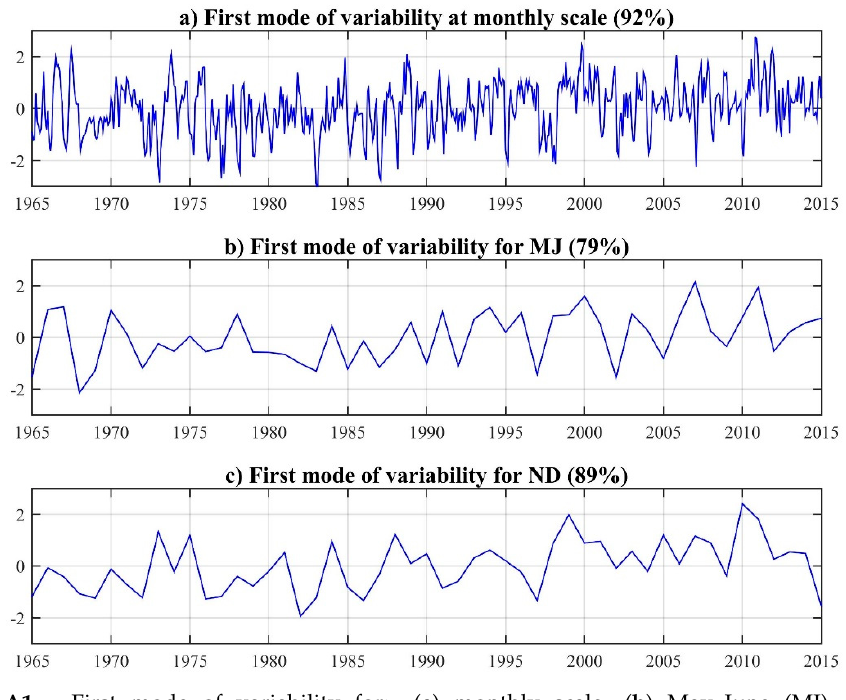
Figure A1. First mode of variability for: ( a ) monthly scale, ( b ) May–June (MJ), and ( c ) November– December (ND). Table A1. Stream gauge station significant correlations at the 0.05 Table A1. Stream gauge station significant correlations at the 0.05 level.